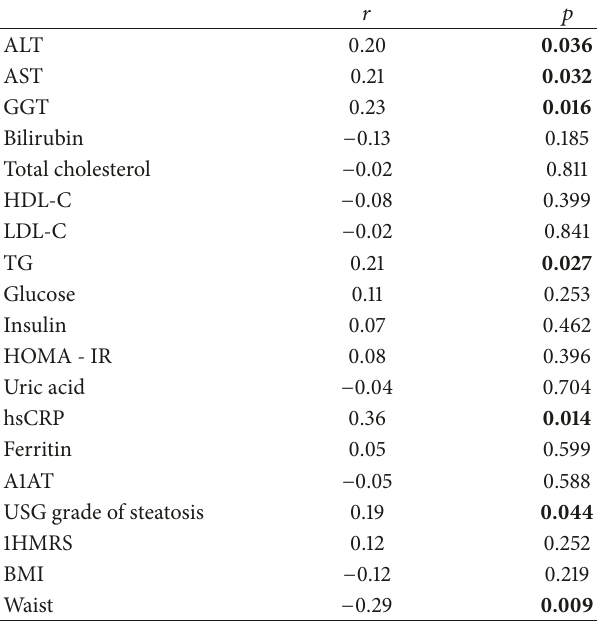
Table 2: Correlation (Spearman) between IL-18 serum concentra- tions and selected parameters.